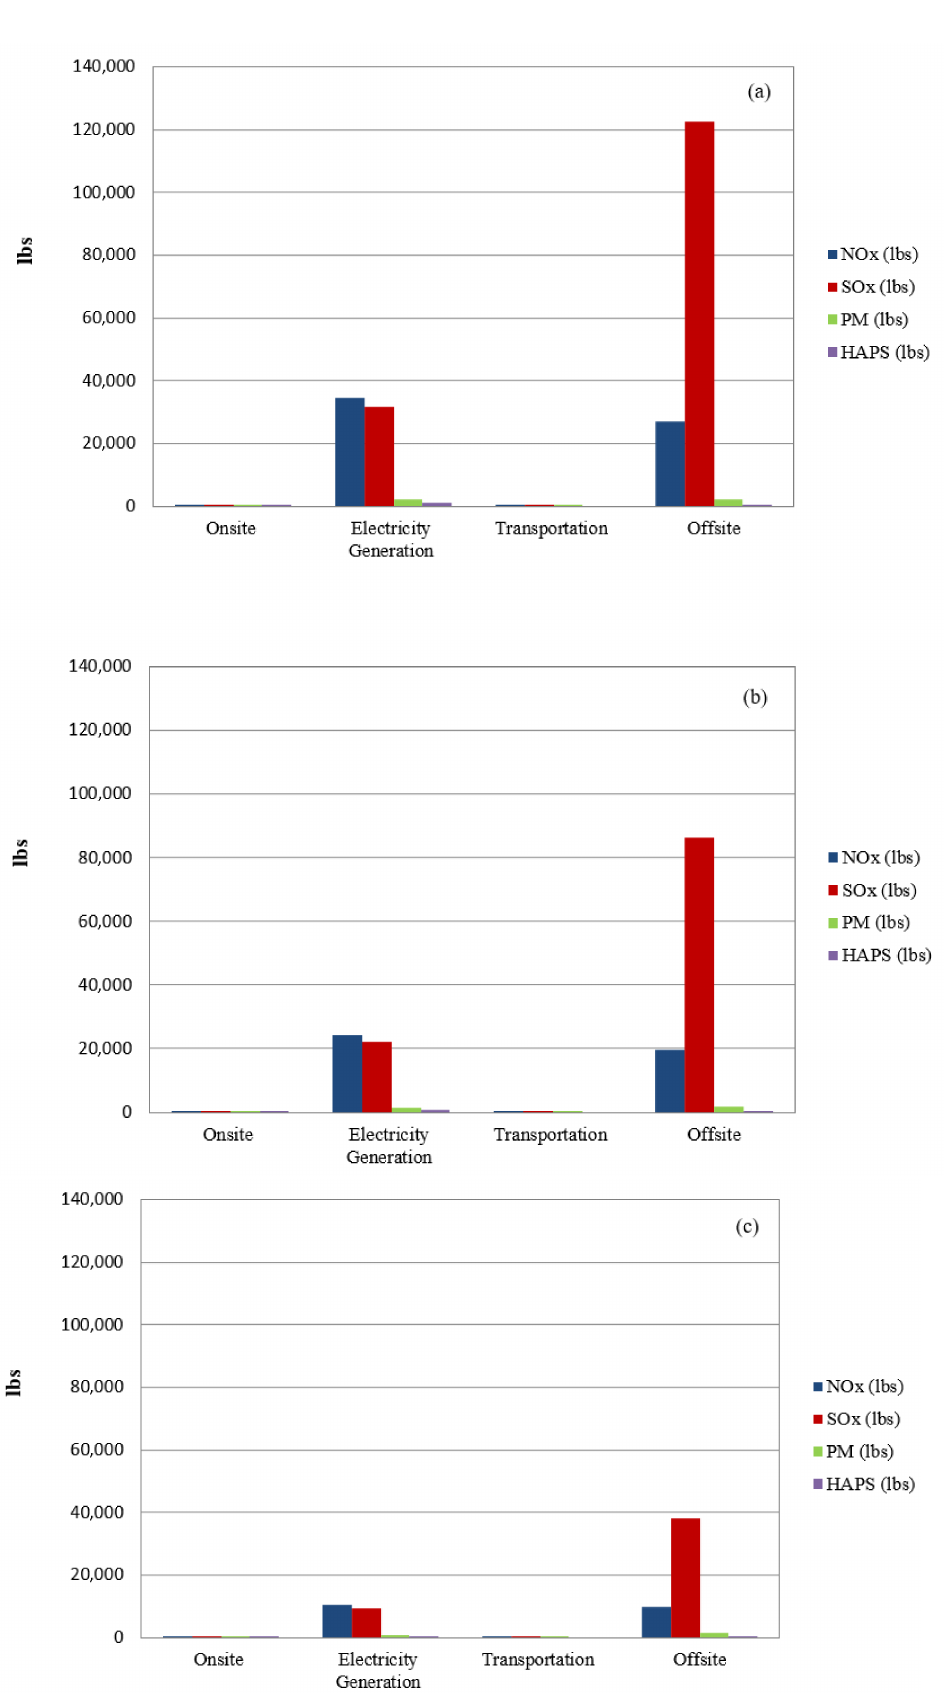
Figure 7. Contributors to the total NOx, SOx, PM and HAP emissions; ( a ) Scenario 1, ( b ) Scenario 2 and ( c ) Scenario